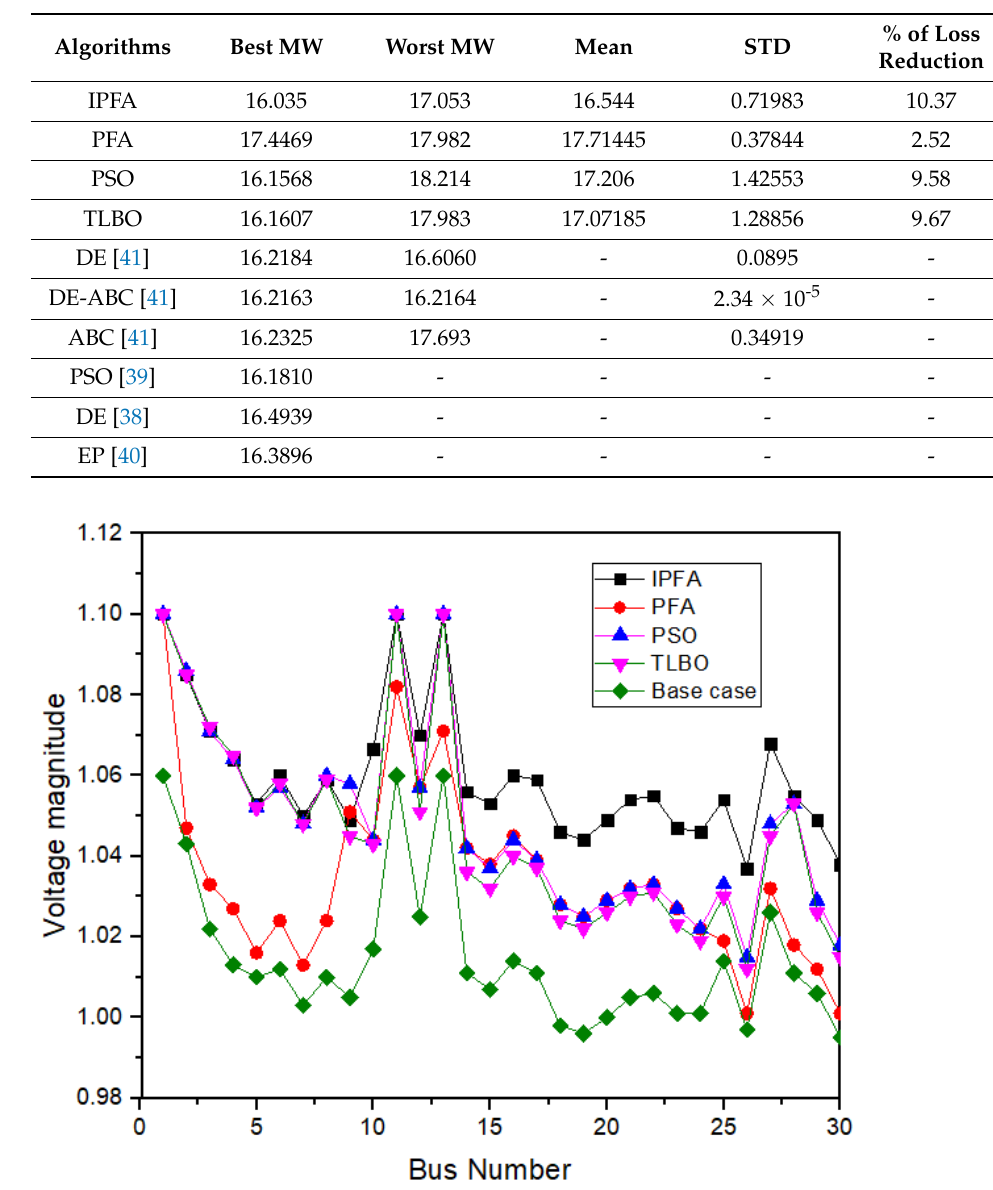
Figure 4. Voltage profile of the IEEE 30 bus system against the bus number